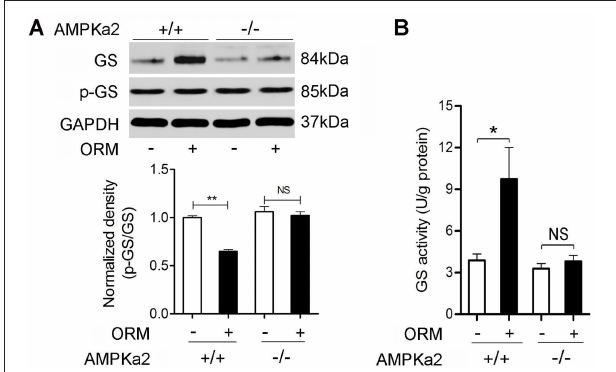
FIGURE 5 | AMPK Mediates the Role of ORM in Promoting the Expression and Activity of Glycogen Synthase in Skeletal Muscles. (A) Representative western blotting of soleus muscle glycogen synthase and phosphorylated glycogen synthase and quantification of the results 30min after the treatment with vehicle or 200mg/kg ORM (tail vein injection) in AMPK α 2 + / + or AMPK α 2 − / − mice. n = 6 per group. (B) The activity of glycogen synthase in soleus muscle of mice treated as mentioned in (A) . n = 6 per group. GS: glycogen synthase; p-GS: phosphorylated glycogen synthase. All data are expressed as the mean ± s.d. NS, non-significant, * P < 0.05, ** P < 0.01 by two-way ANOVA with Turkey’s post-hoc test.